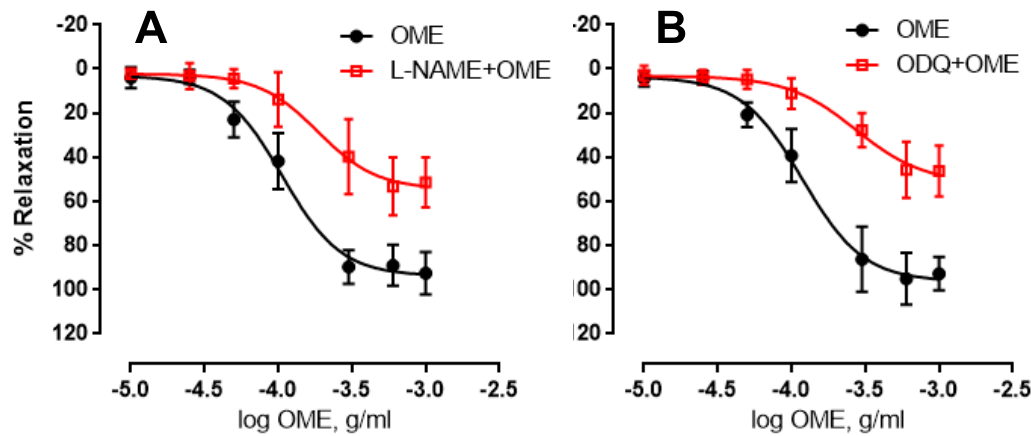
Figure 3. Role of nitrous oxide (NO) or cGMP in OME-induced relaxation. ( A ) Endothelium-intact rings were treated with cumulative doses of OME in the presence (red) or the absence (black) of N ω -nitro- l -arginine methyl ester (L-NAME) (inhibitor of eNOS, 100 µ M). Data represent mean ± SEM ( p < 0.01 for OME alone vs. L-NAME plus OME; n = 7). ( B ) Endothelium-intact rings were treated with cumulative doses of OME in the presence (red) or absence (black) of ODQ (inhibitor of soluble guanylate cyclase, 1 µ M). Data represent mean ± SEM ( p < 0.01 for OME vs. ODQ plus OME; n =